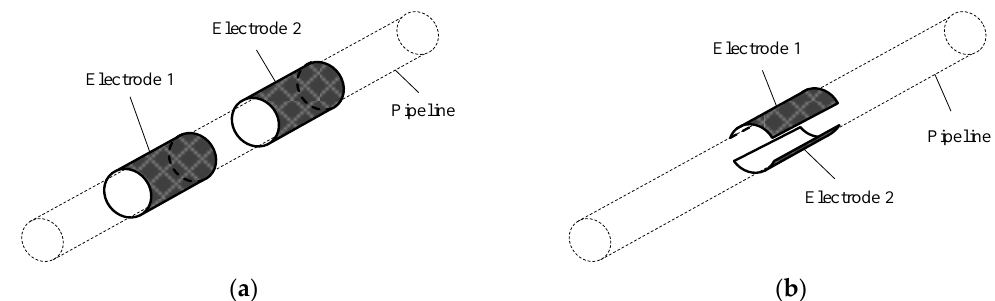
Figure 2. The C 4 D sensor with different electrode configurations: ( a ) Tubular configuration; ( b ) Radial configuration. Notation: For the tubular configuration (as illustrated in ( a )), a pair of cylindrical electrodes is attached around the pipe. For the radial configuration (as illustrated in ( b )), a pair of concave electrodes is attached to the pipe oppositely.